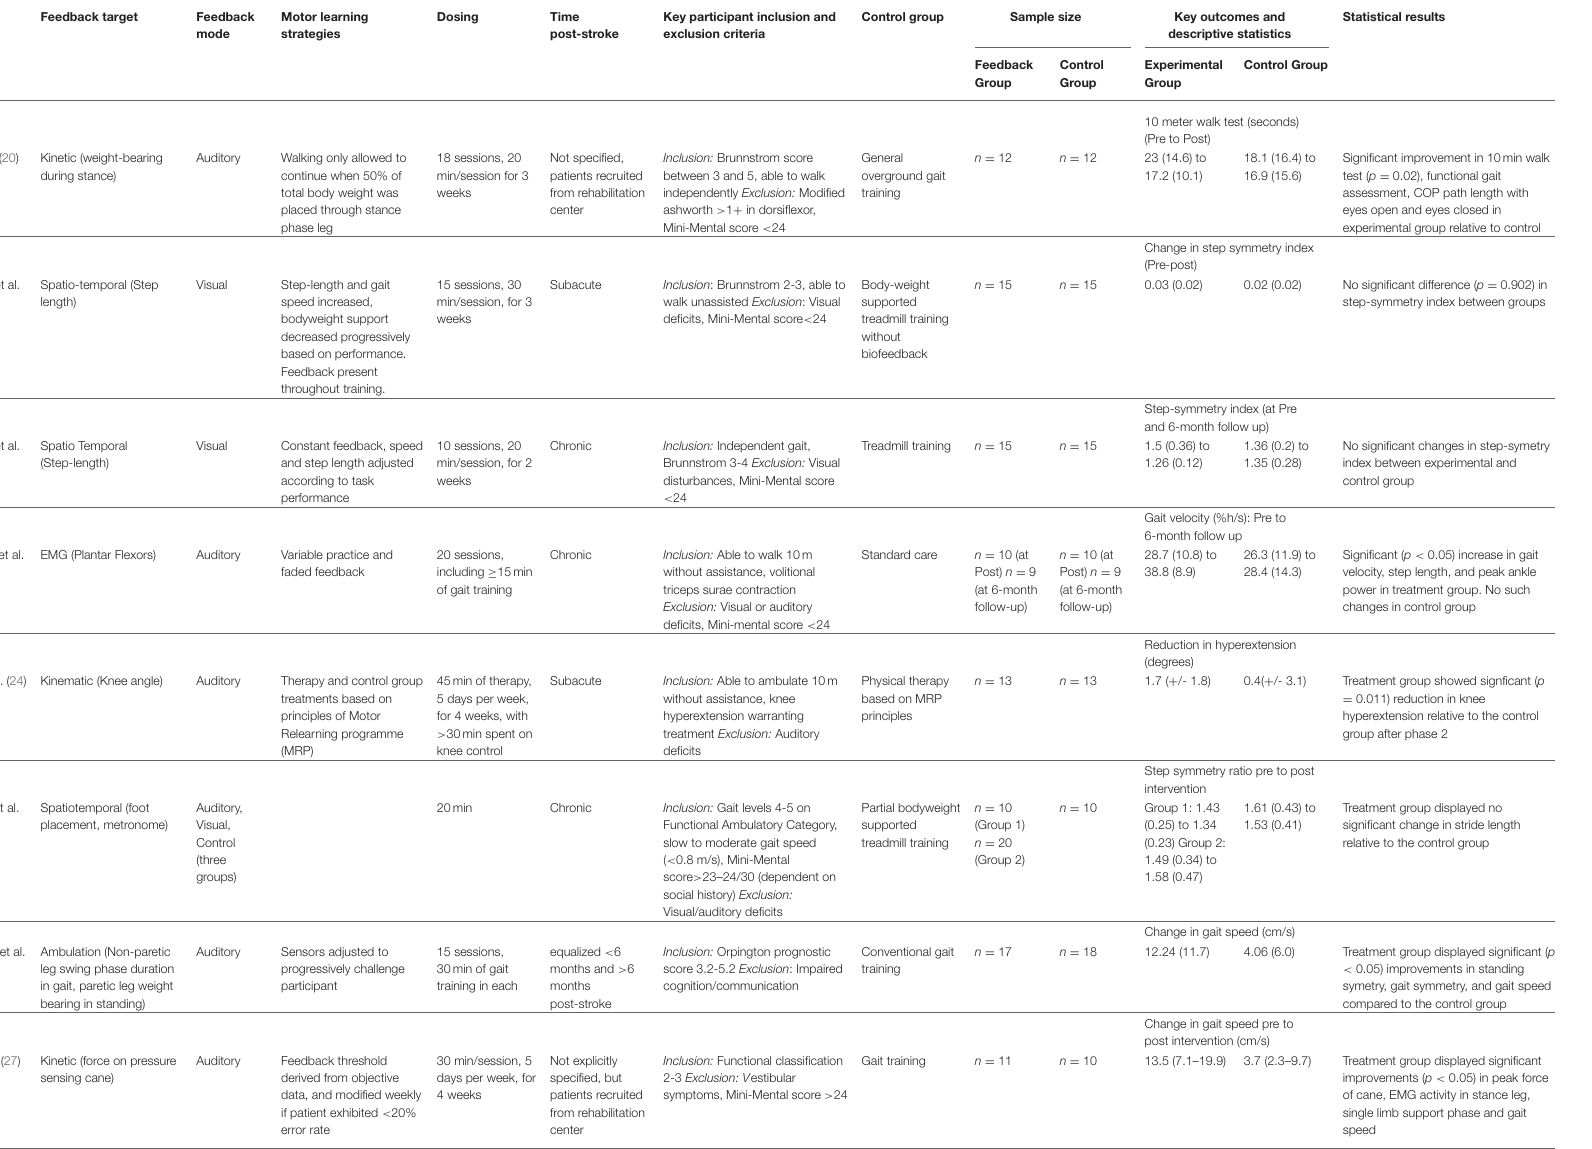
The table lists that received scores of ≥ 6/10 (moderate to high quality) on the Physical Therapy Evidence Database (PEDro) scale. All studies included in this table evaluated the relative efficacy of a biofeedback intervention provided during non-robotic gait training and compared to a non-biofeedback control group. The descriptive statistics are listed as average (standard